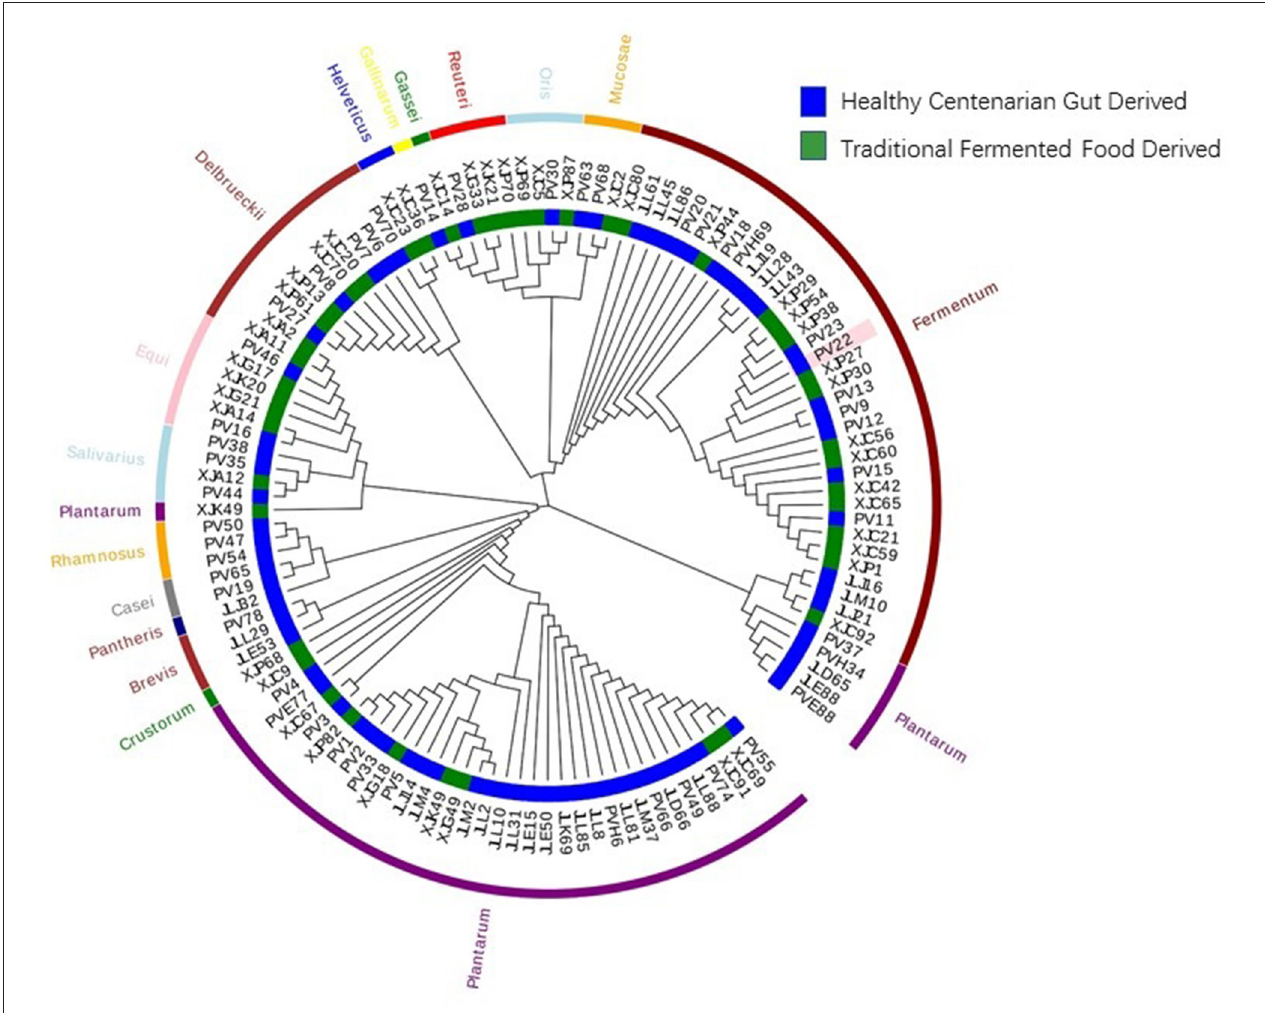
FIGURE 1 | Phylogenetic tree of the 122 strains of lactic acid bacteria (LAB). The phylogenetic tree of 122 LAB strains was constructed based on 16S rRNA sequences using the neighbor-joining method. The inner circle of the phylogenetic tree indicates the sources from which each LAB strain was isolated. The outer circle of the phylogenetic tree indicates the species of the LAB strains.